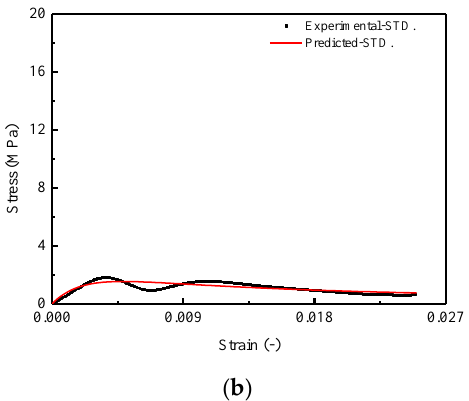
Figure 12. Comparison between experimental and theoretical stress–strain curves for CA mortar: ( a ) Mean stress–strain curve; ( b ) STD. of stress–strain curve.